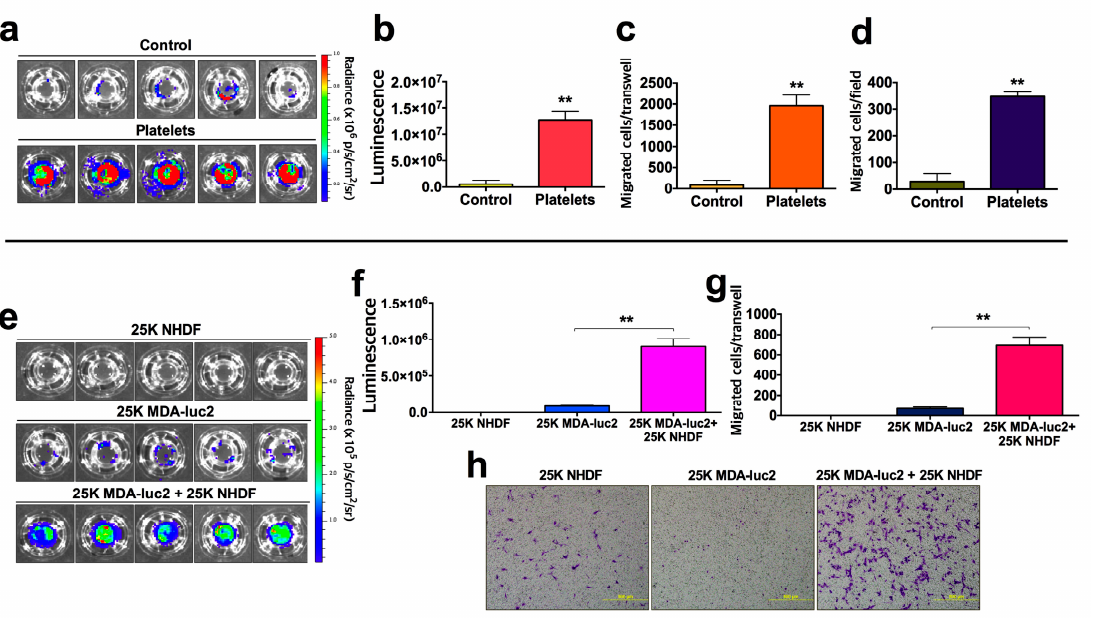
Figure 5. Comparison of bioluminescence and classical migration assays in tumor cell:platelet and tumor cell:stromal cell interaction experiments. ( a ) 4T1-luc2 mammary adenocarcinoma cells were incubated in transwells for 24 h with (n = 5) or without (n = 5) isolated mouse platelets, then the migrated tumor cells imaged using the bioluminescence method. ( b ) Bar graph of luminescent signal obtained from ( a ). ( c ) Conversion of data in ( b ) to number of migrated tumor cells per transwell based upon previously determined luminescence/cell values. ( d ) Number of migrated tumor cells per transwell were determined using crystal violet staining and quantification by Image-Pro Plus from three random microscopic fields. ( e – g ) MDA-luc2 tumor cells and NHDF cells (fibroblasts) were incubated separately and together (n = 5) for a 24 h period, then the number of migrated MDA-luc2 tumor cells per transwell determined using the bioluminescence method. ( h ) Migrated cells per transwell were imaged following crystal violet staining using light microscopy (100× magnification), with tumor cells. As one cell type is indistinguishable from the other using this method, a count of migrated tumor cells could not be obtained. Bars represent SEM. ** p < 0.01 (unpaired t -test).